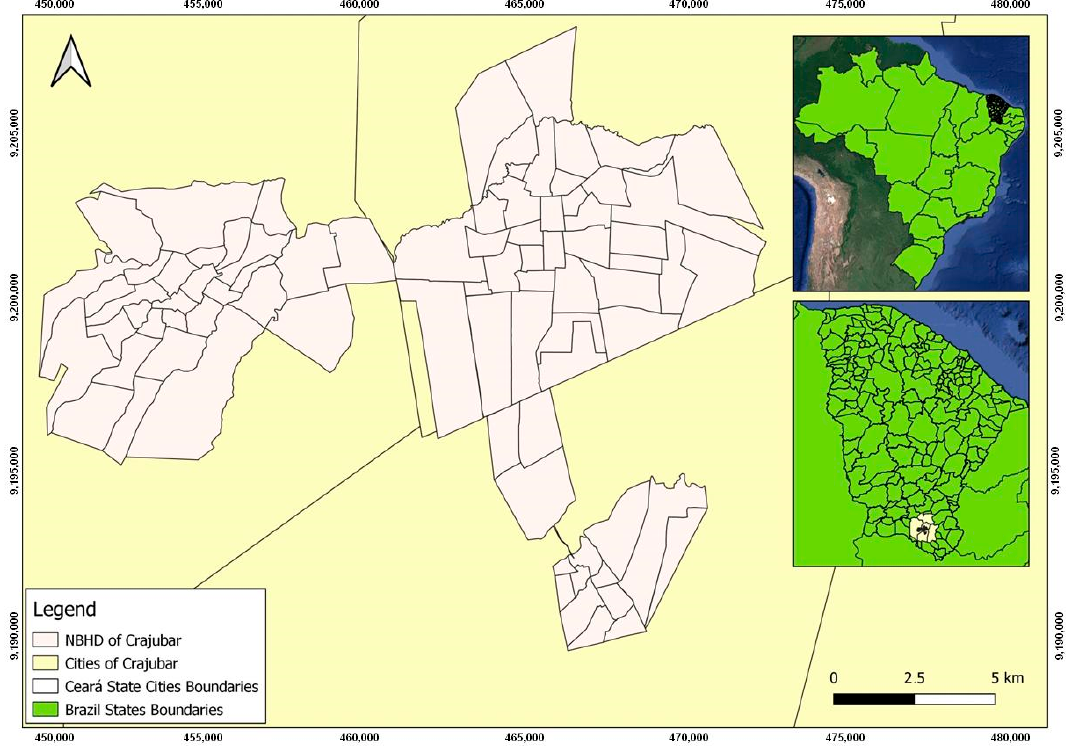
Figure 1. Geographic location and neighborhoods in the conurbation of the Crajubar region. Crajubar’s high potential for economic development enshrines it as a large secondary